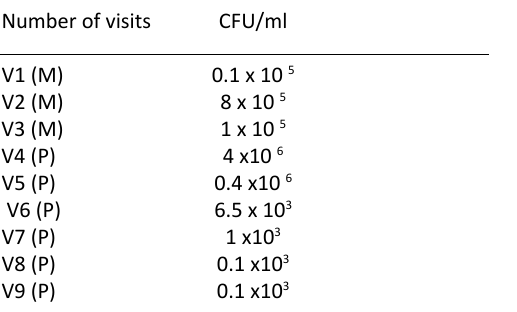
table 1. Total bacterial count (CFU/ml) of Domiaty cheese Number of visits